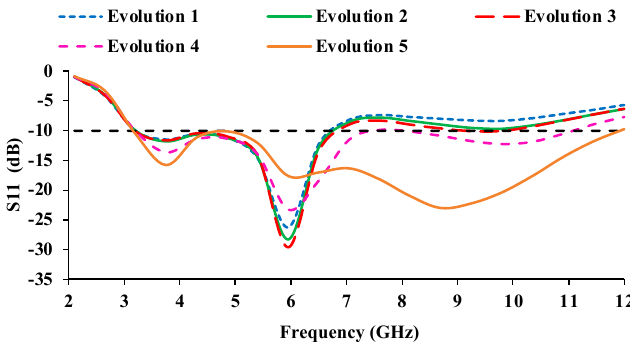
Figure 3. S 11 (dB) curves of the evolution stages.